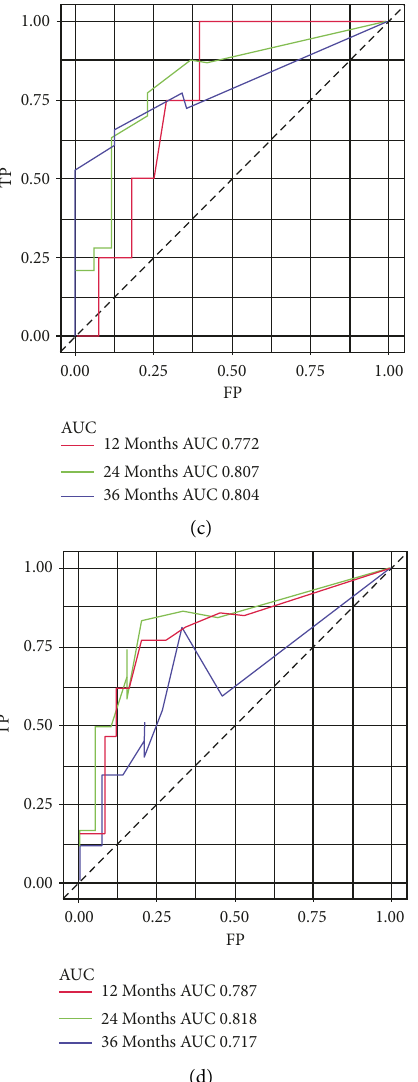
Figure 4: Prognostic nomogram for predicting the overall survival of young osteosarcoma patients with LM (a); three time-dependent receiver characteristic curves to show the discrimination of prognostic nomogram in the training set (b), internal validation set (c), and external validation set